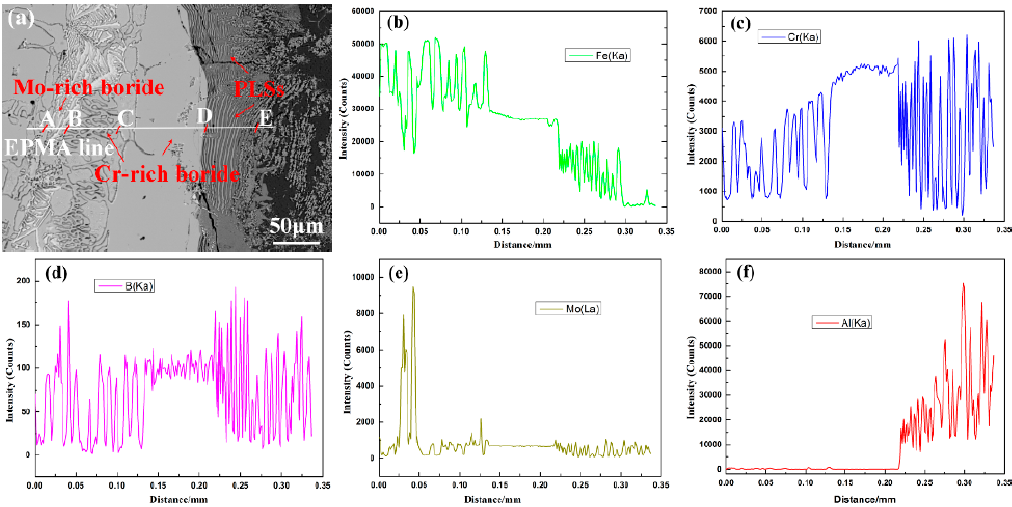
Figure 8. EPMA analysis of the corrosion layer along line segment AE for sample M3 at 750 °C for 8 h in molten aluminum; ( a ) BEI; ( b ) Fe; ( c ) Cr; ( d ) B; ( e ) Mo; ( f ) Al.